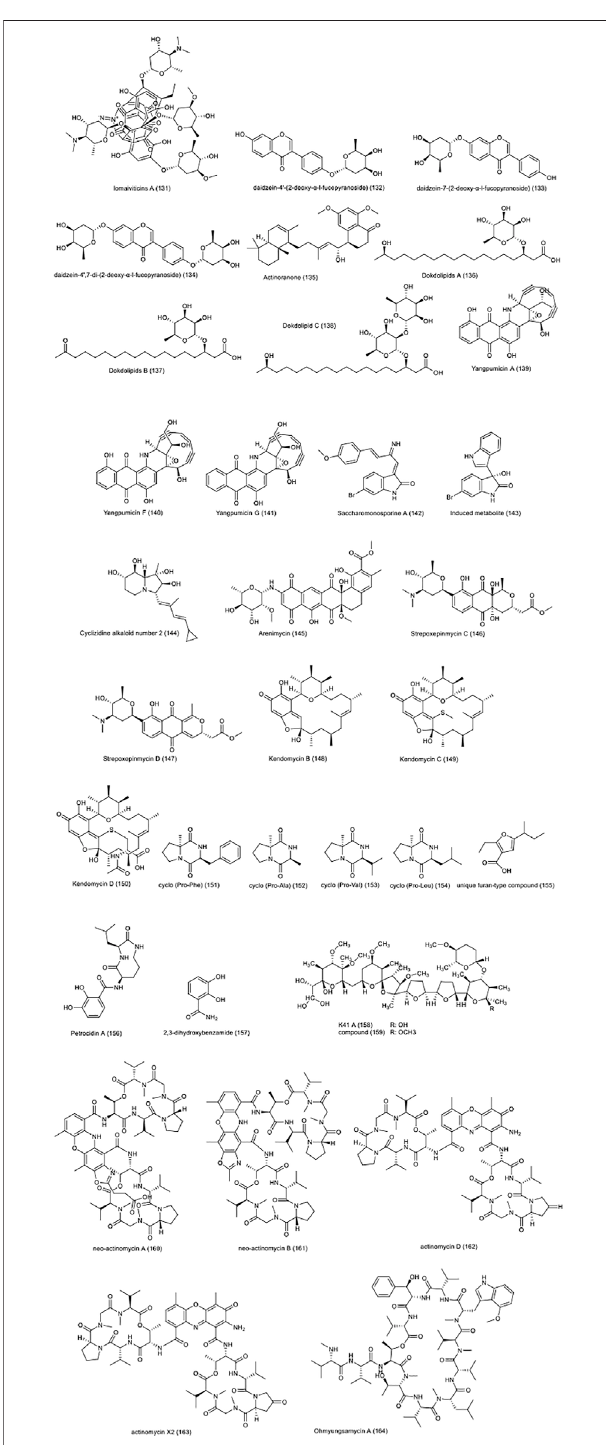
FIGURE 5 | Chemical structures of NPs 131 – 164, and other NPs with anti-CRC properties from marine actinobacteria.